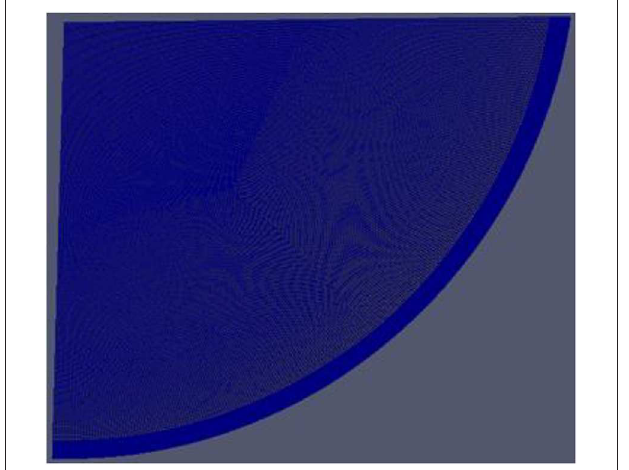
FIGURE 1 | Mesh setup of the COPRA.